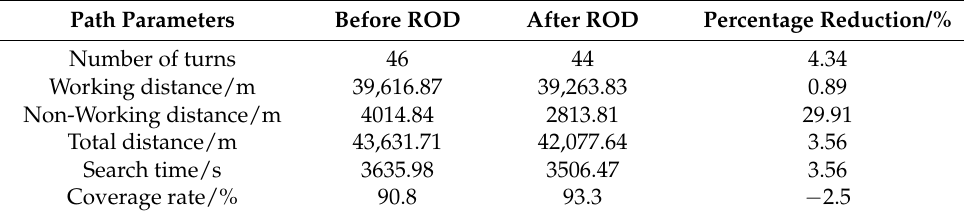
Table 9. Path comparison of detection area 2 before and after ROD.